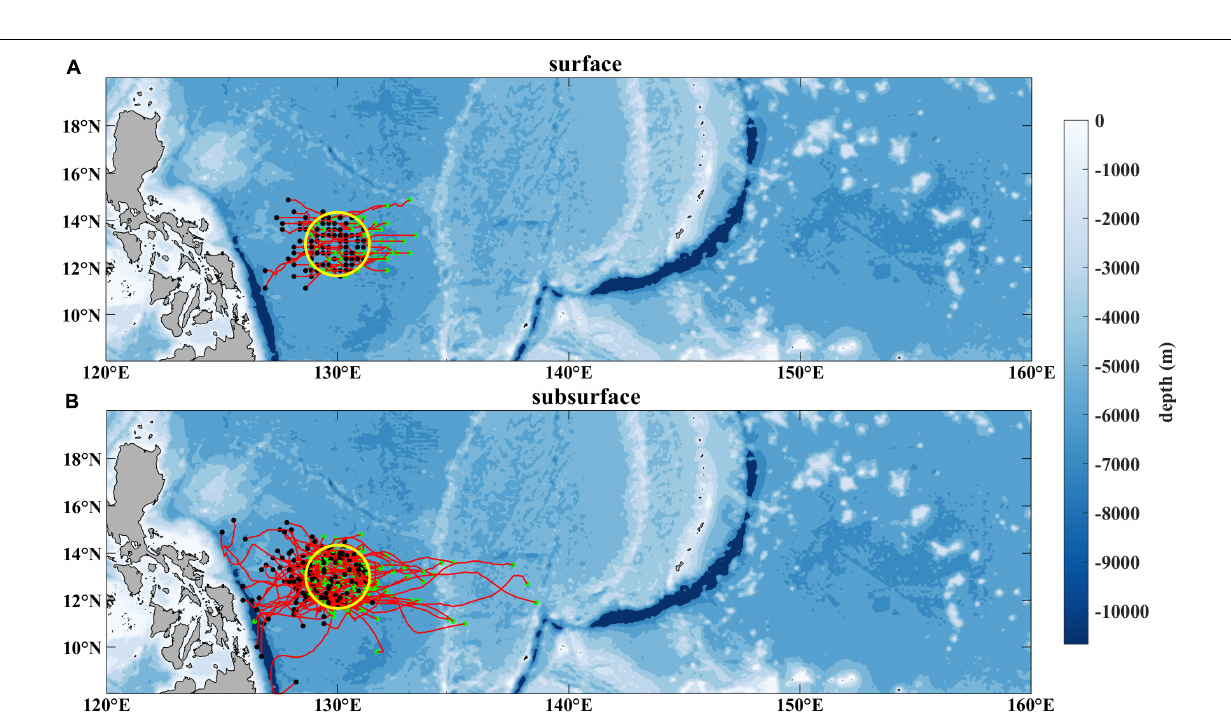
FIGURE 9 | (A) Trajectories (red curves) of all the surface eddies that can affect the currents at 13 ◦ N, 130 ◦ E during 2010–2016 derived from the AVISO data. (B) same as (A) , but for subsurface eddies derived from OFES outputs in the same period. The green dots denote the origins of those eddies and the black dots denote their destinations. The yellow circle denotes the region centering at the mooring location with a radius of 150 km.